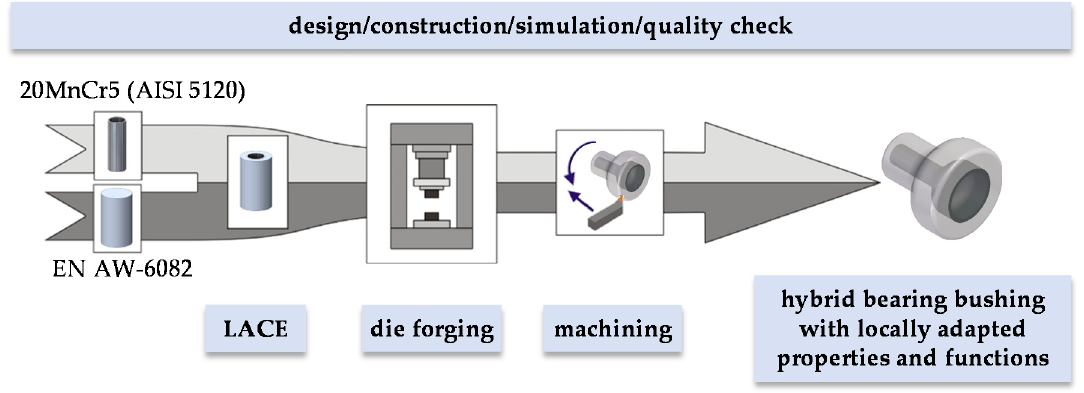
Figure 1. Tailored forming process chain for the production of hybrid bearing bushings.